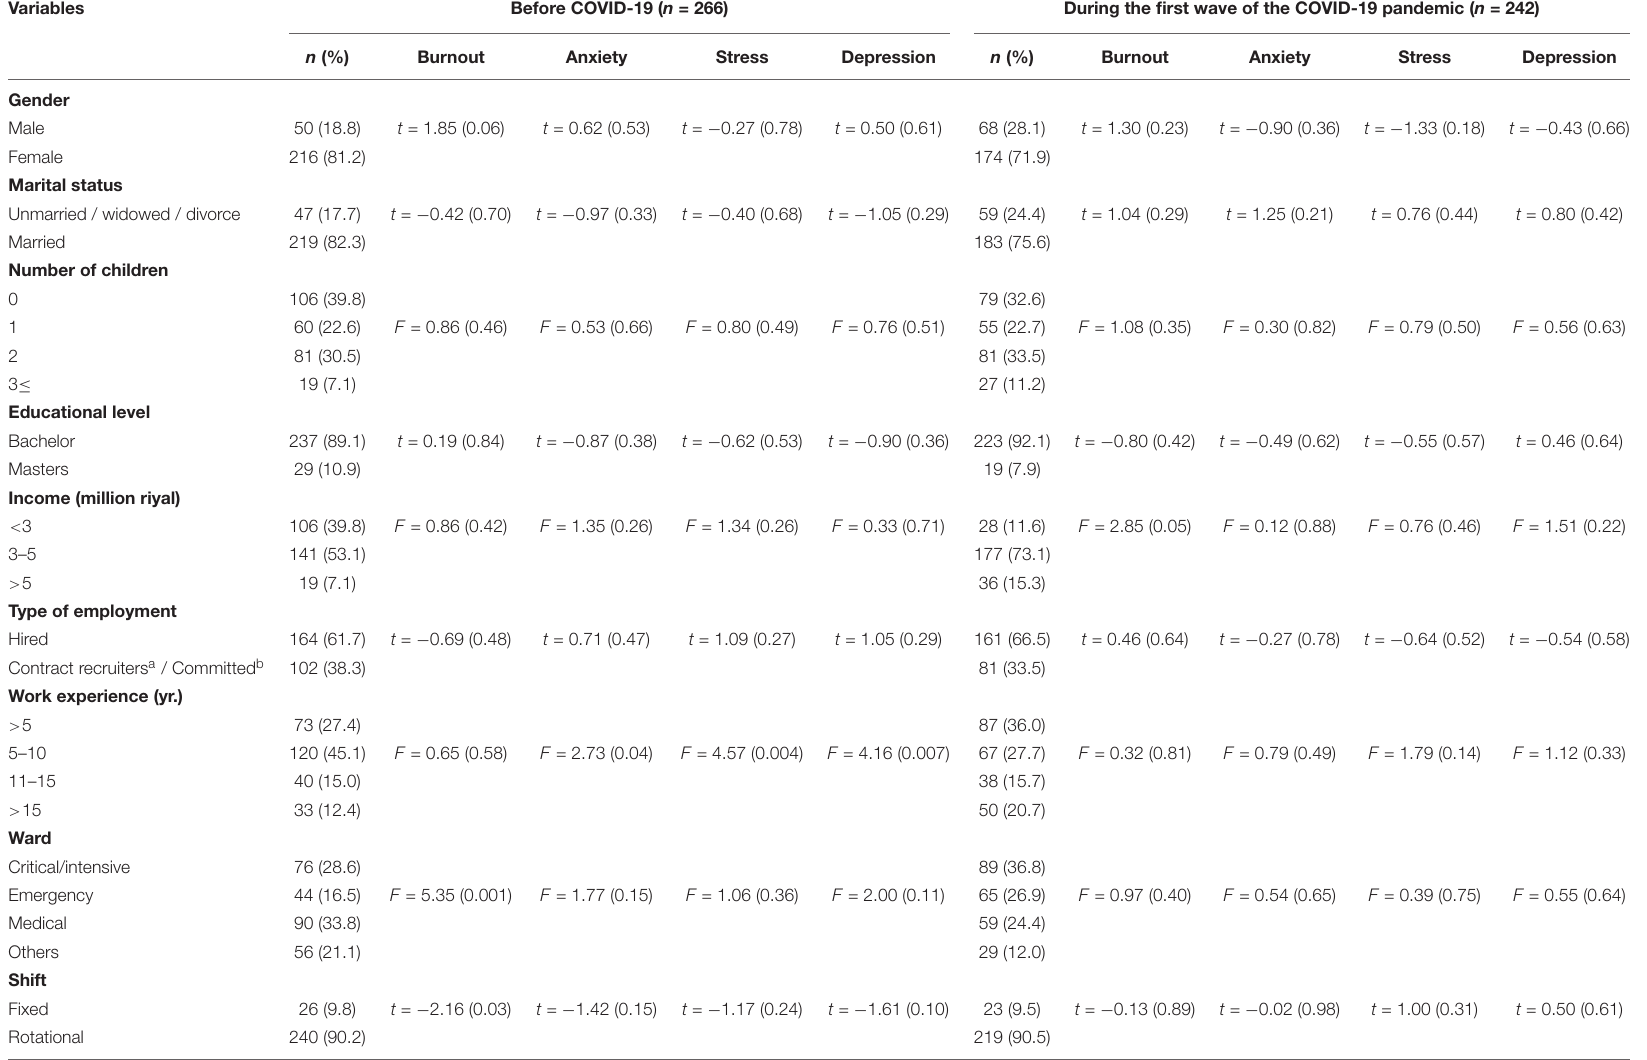
TABLE 1 | Comparison of the demographic characteristics of the participants before and during the first wave of the COVID-19 Pandemic. Variables Before COVID-19 ( n = 266) During the first wave of the COVID-19 pandemic ( n = 242) Anxiety Stress Depression